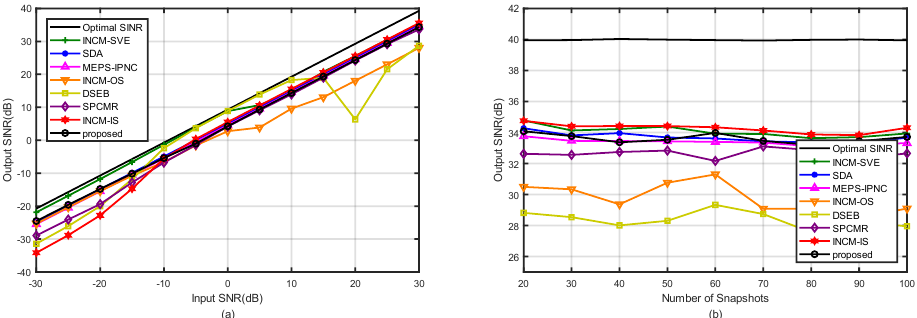
Figure 4. Output SINRs in the case of the look direction error versus ( a ) input SNRs with 𝐾 = 100 ; ( b ) the number of snapshots with 𝑆𝑁𝑅 = 30 dB .